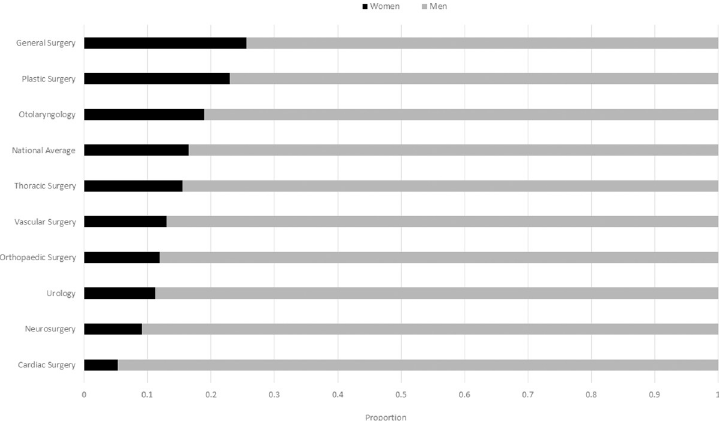
Fig 1. Proportion of women to men academic surgeons by specialty. Ordered from highest proportion of women surgeons to lowest proportion. Significant differences exist between specialties (p < 0.0001).